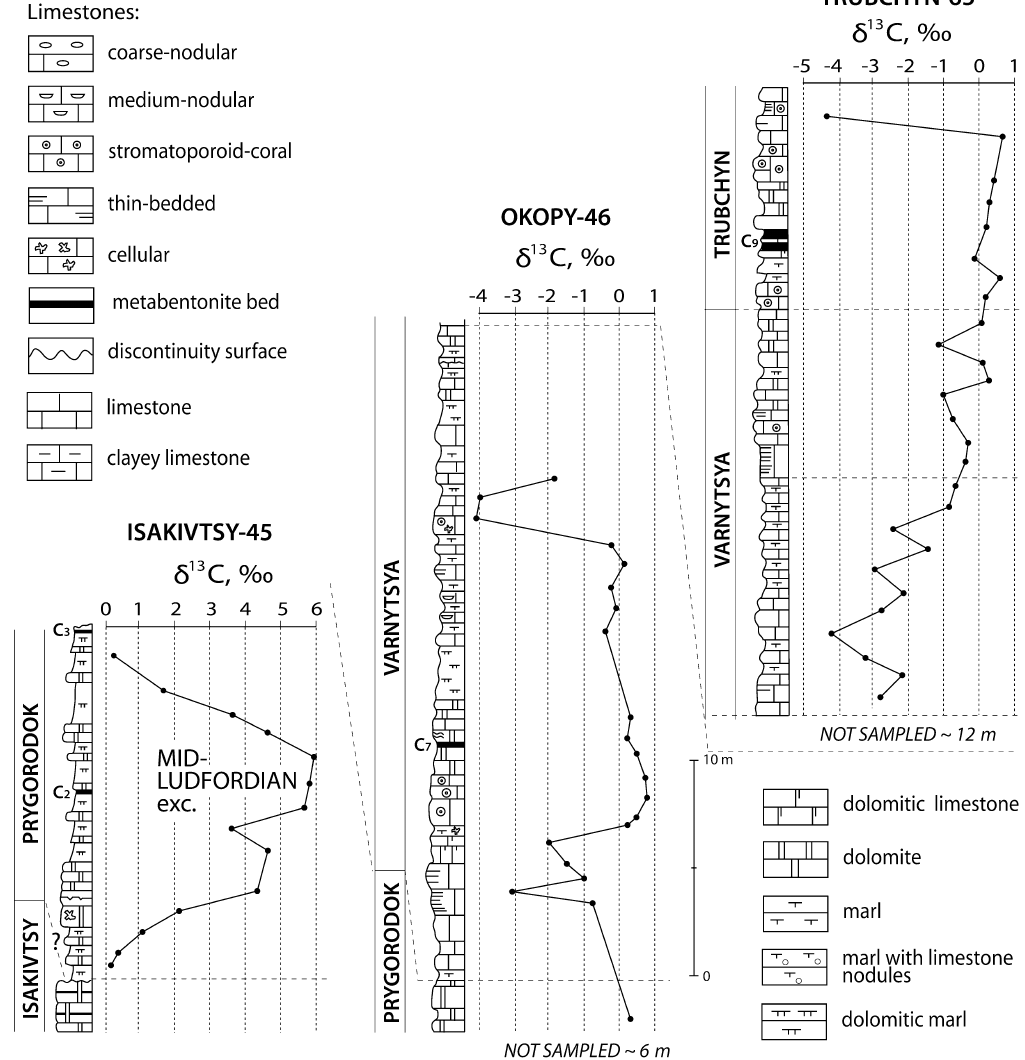
Fig. 4. Upper Ludlow and lower P ř (cid:237)dol(cid:237) δ 13 C curves from the Dniester area. Log and lithostratigraphy from Tsegelnyuk et al. (1983). Note sampling gaps in the upper Prygorodok and within the Varnytsya Fms. For explanations see